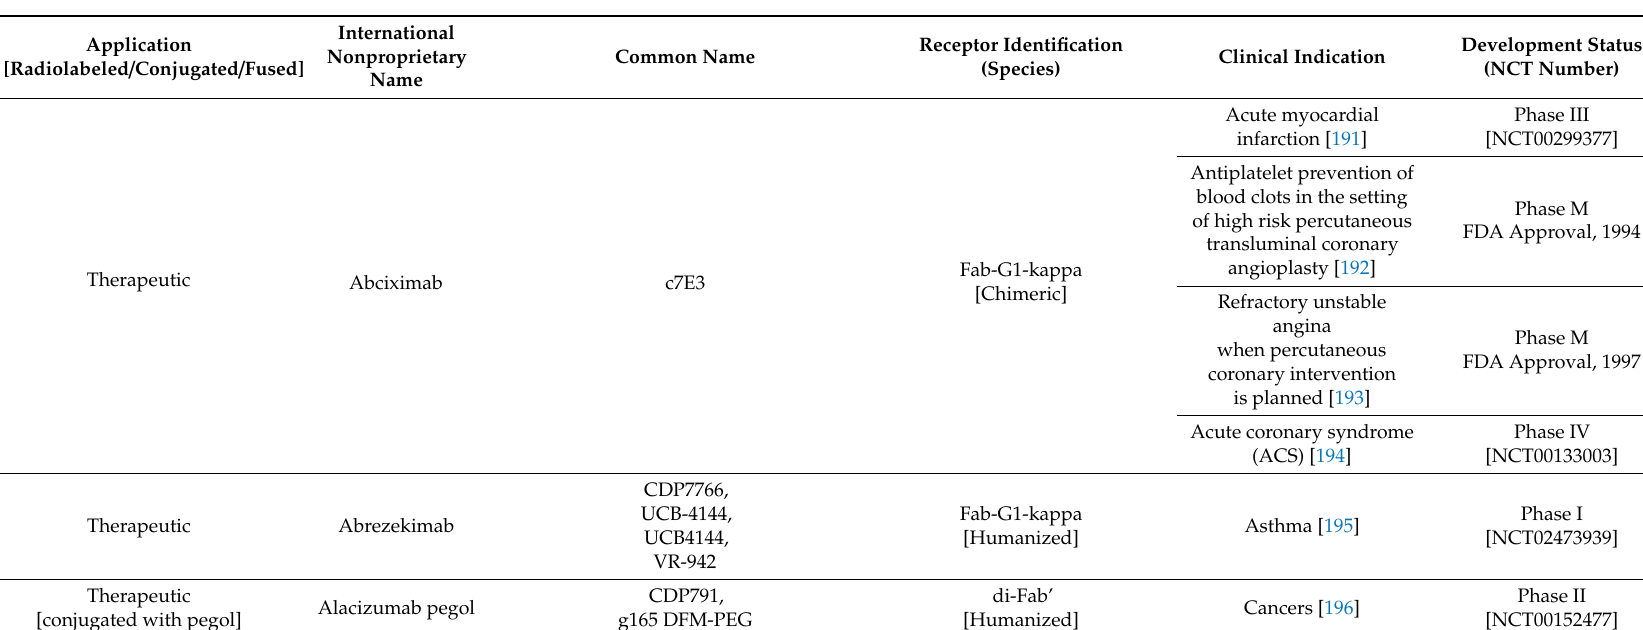
Table 1. Antibody fragments and formats under clinical development and FDA-approved. Sources: European Medicines Agency public assessment reports, United States Food and Drug Administration (drugs@fda), the international ImMunoGeneTics Information System ® (www.imgt.org / mAb-DB / index), Animal Cell Technology Industrial Platform